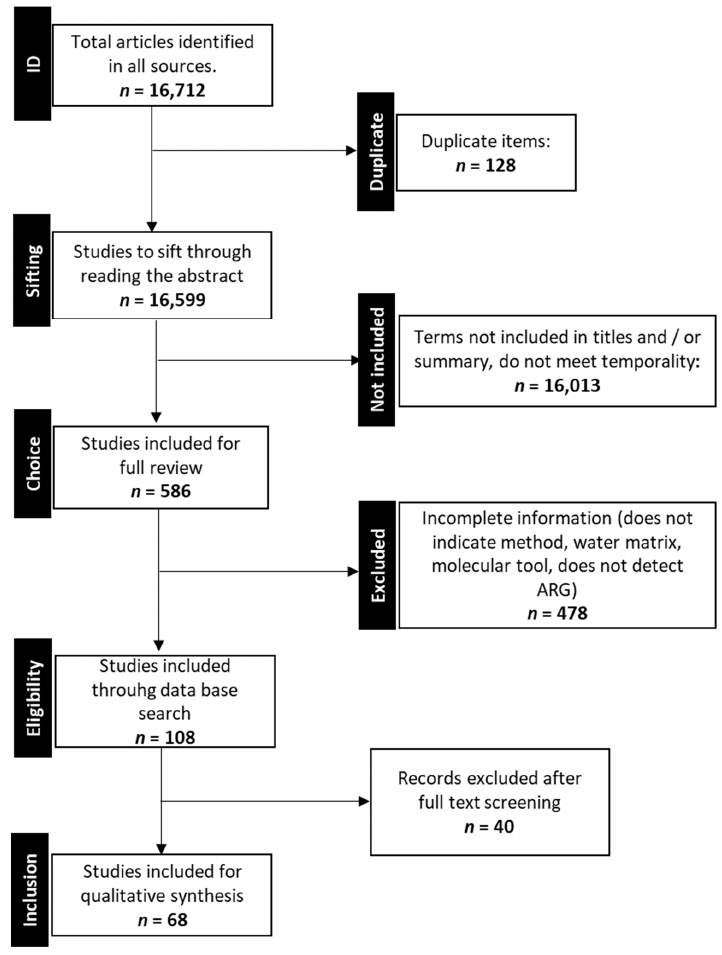
Figure 1. Flow diagram of search strategy and selection of articles reporting the structure of bacterial populations with resistance to antibiotics in aquatic environments.